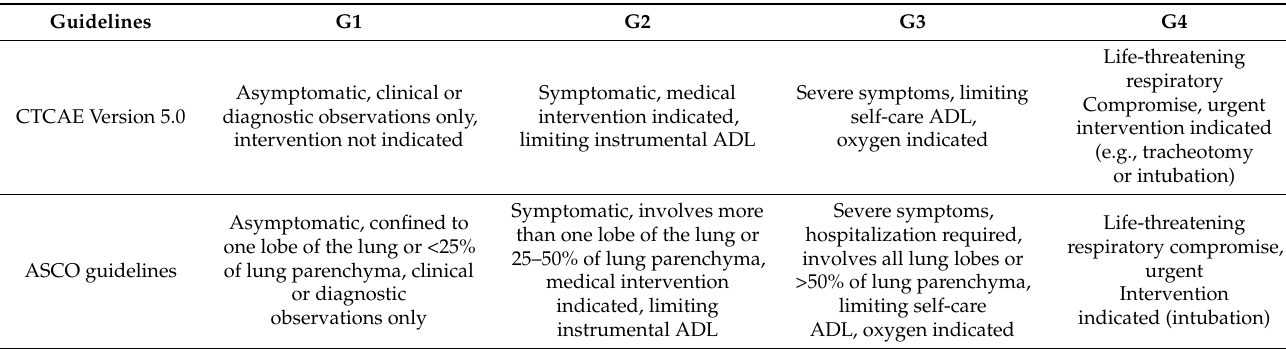
Table 4. Pneumonitis severity classification according to NCI-CTCAE version 5.0 and American Society of Clinical Oncology (ASCO) 2018